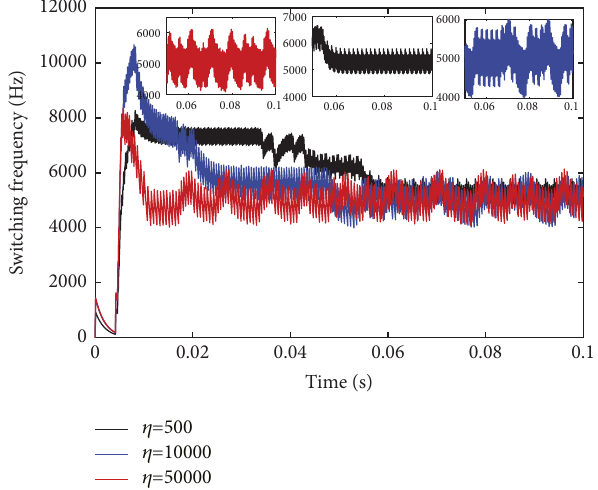
Figure 10: Te efect of the FCL integral constant to the switching